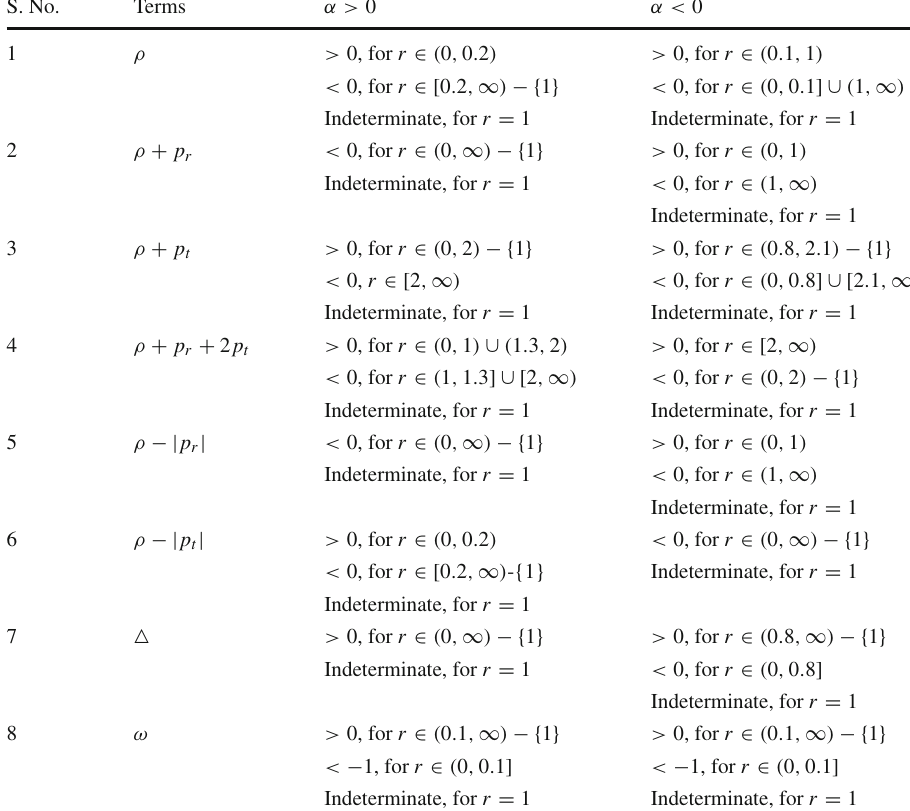
Table 5 Summary of results for φ( r ) = constant with n =